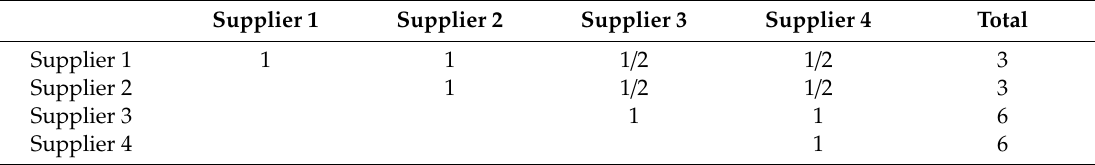
Table 9. The results of pairwise comparison for supplier alternative with regard to quality system criterion.